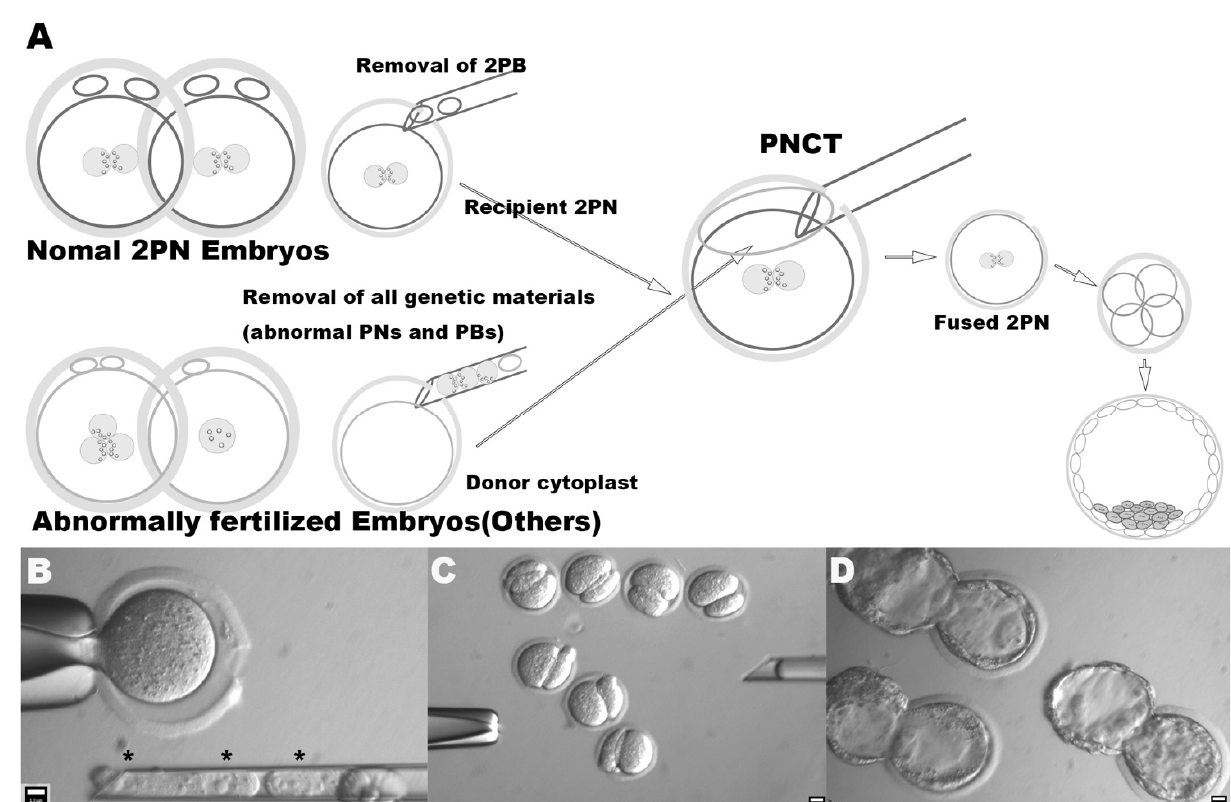
Figure 1. Schematic diagram of PNCT. ( A ) Figure depicts PNCT procedure. Embryos are classified to either normal 2PN embryos or abnormally fertilized embryos. Whereas only 2PBs are removed from the 2PB recipient, all genetic materials are removed from the abnormally fertilized embryo and create the nuclear-free donor cytoplast. Donor cytoplast was isolated followed by brief exposure to HVJ-E. Cytoplast was then transferred into the perivitelline space of recipient 2PN zygotes. ( B ) Figure depicts the removal of 3PNs and 2PBs from 3PN embryos to create nuclear DNA-free donor cytoplast. Asterisks indicate removed 3PNs within pipette. ( C ) Figure depicts post-PNCT embryos prior to fusion occurring. The perivitelline space of recipient 2PN embryos was filled with transferred cytoplast. ( D ) Figure depicts blastocysts derived by PNCT. Original magnifications of ( A – C ) are 320×, 200×, and 300×, respectively. * Asterisk indicates enucleated PNs within pipette.